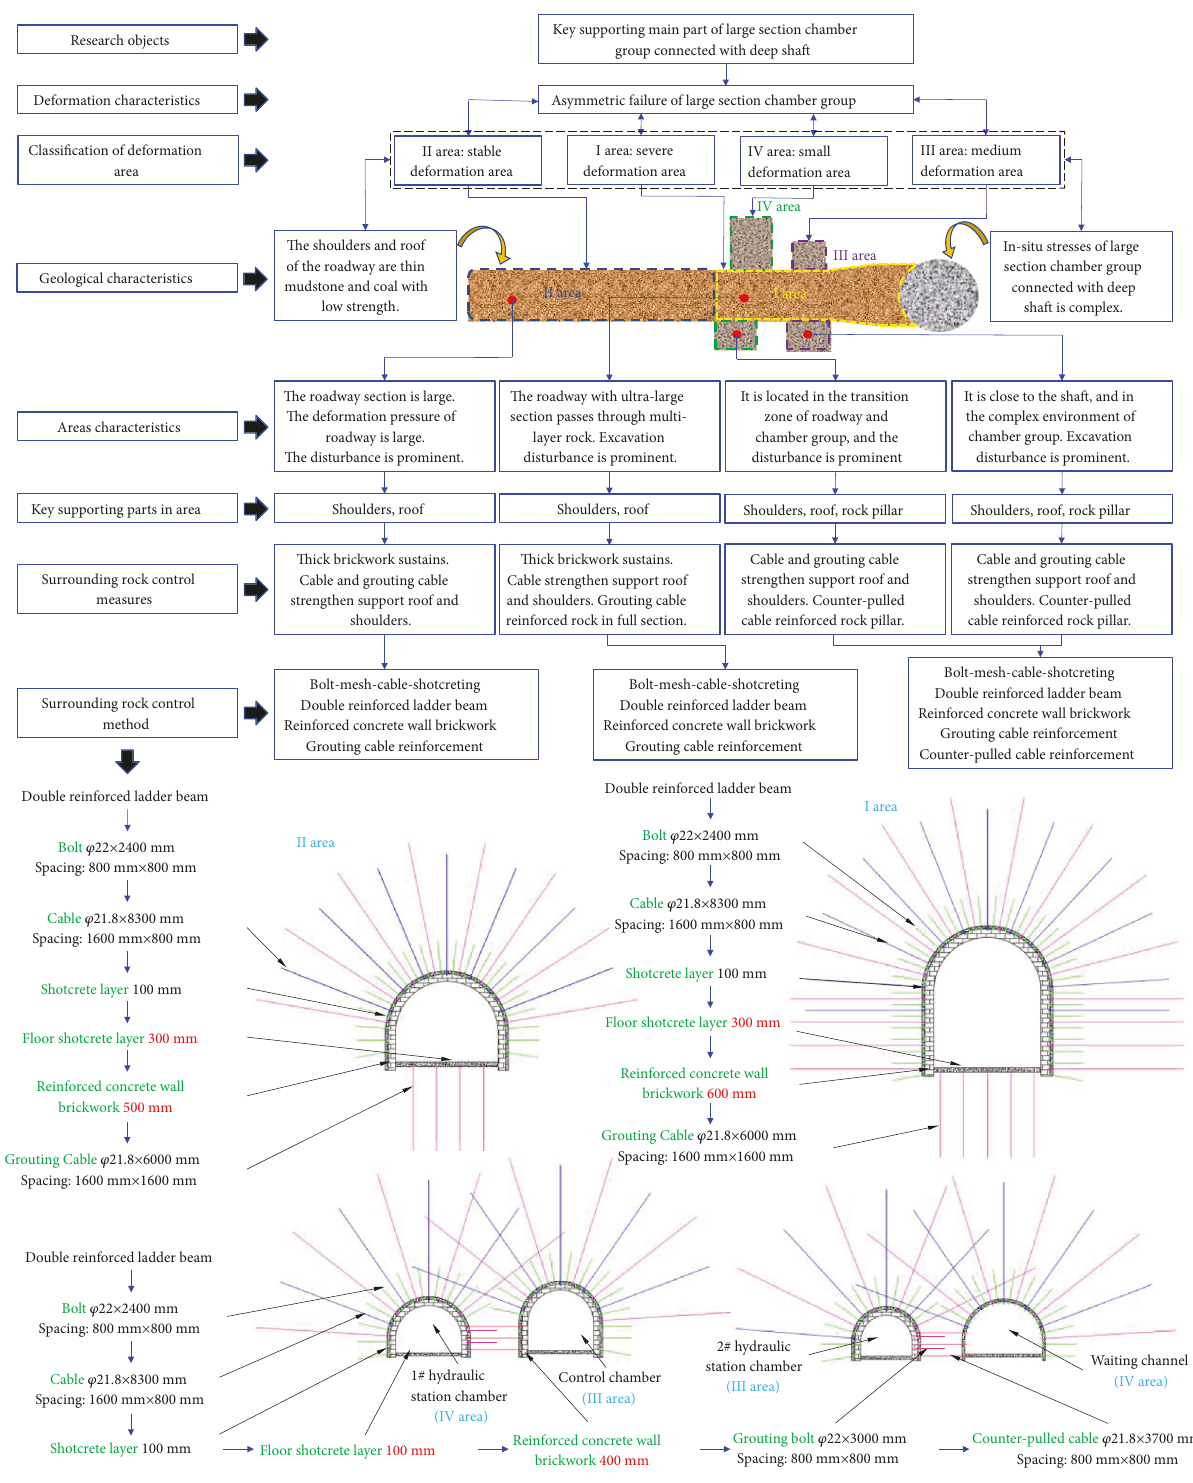
Figure 14: Basic control ideas and technical methods of surrounding